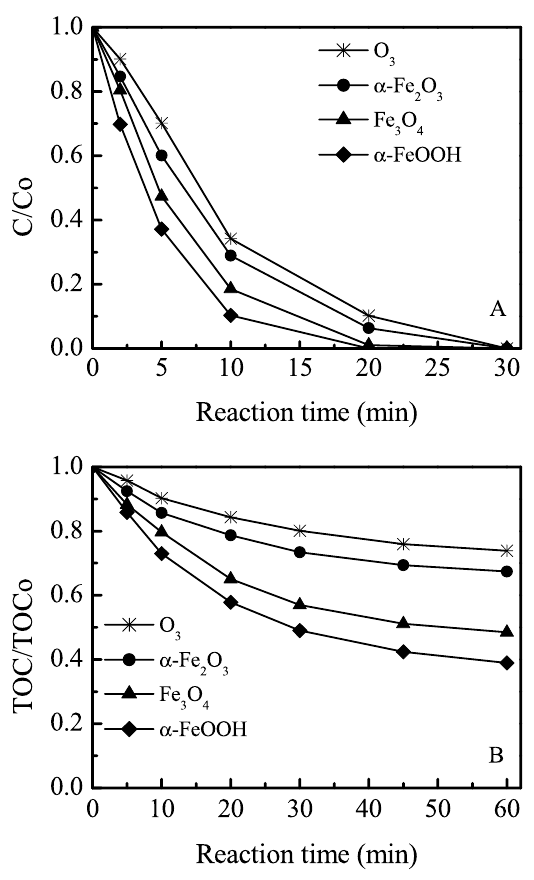
Figure 9. ( A ) Catalytic ozonation of IBU in various suspensions. ( B ) TOC removal. (Initial pH = 7.0,